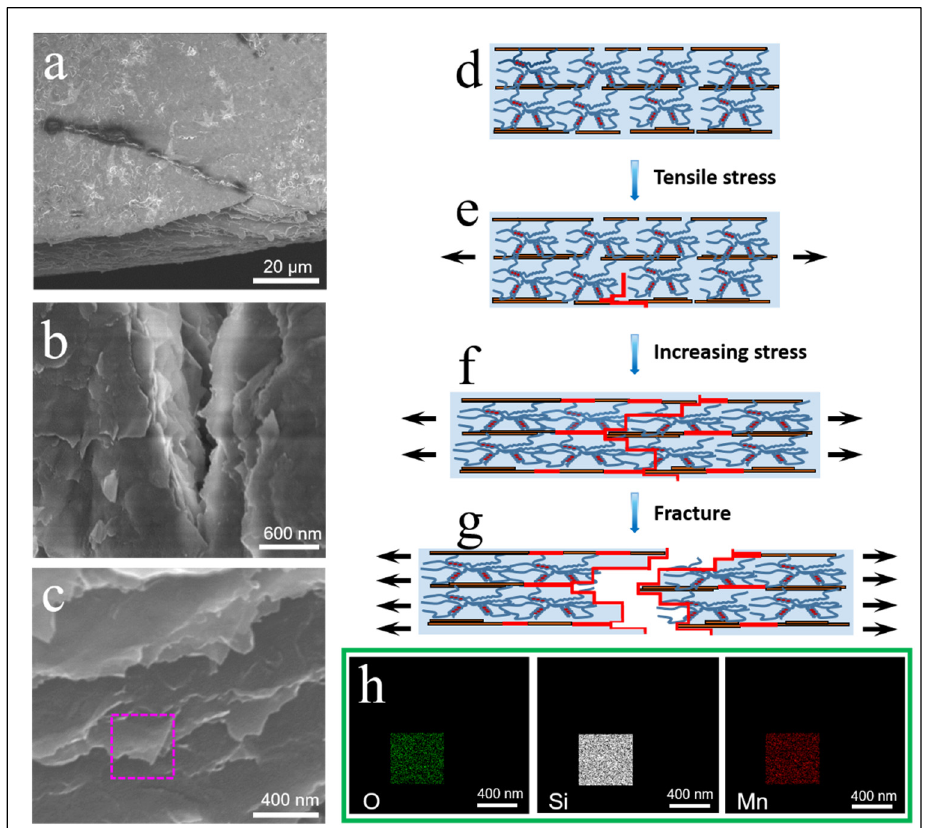
Figure 5. ( a – c ) Fracture morphology of the nacre-like film. ( a ) Crack deflection. ( b ) Interlaced pull-out of MMT nanosheets at the crack tip. ( c ) Under the synergistic action of hydrogen bond and ion crosslinking, MMT nanosheets slipped out and crimped at the edge. ( d – g ) Proposed synergistic mechanism of MMT-ALG-X 2+ bioinspired nanocomposites. ( h ). EDS mapping of the MMT-ALG-Co 2+ (Figure 5c pink rectangular area).